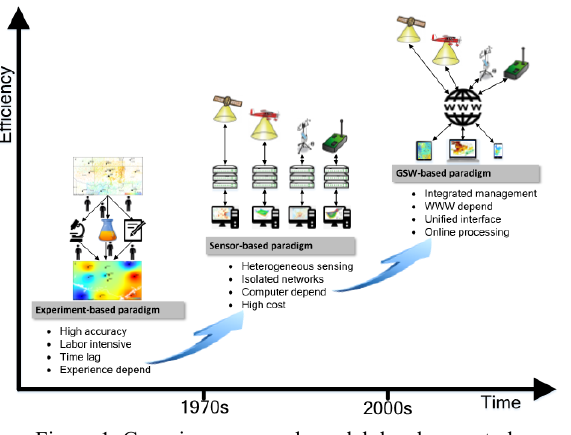
Figure 1. Geoscience research model development plan However, with the iterative update of sensor technology and the Internet of Things technology, the earth observation system is gradually developing from the Internet to the Internet of Things. Things